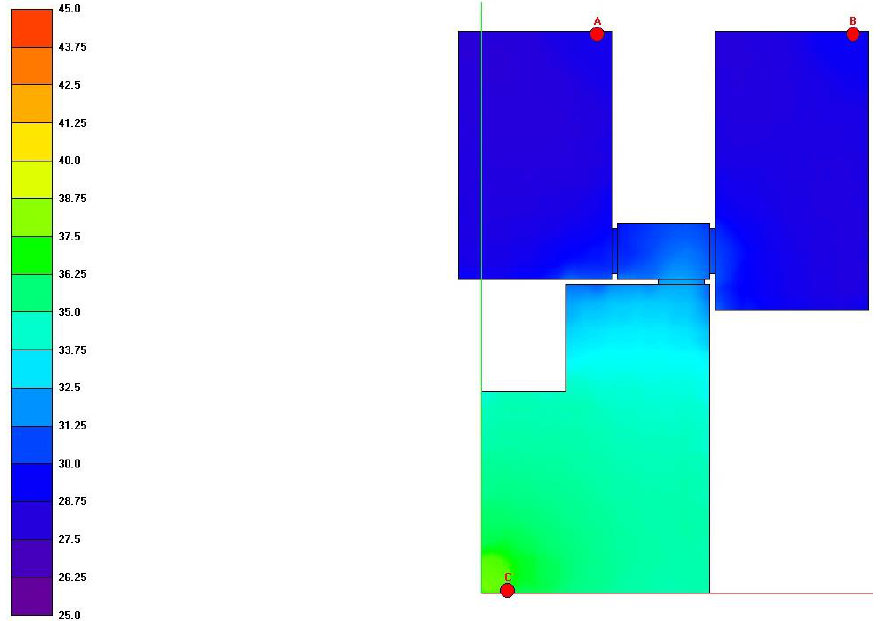
Figure 10. CM CMV A-weighted sound power levels L wA . First of all, the rooms surface absorption coefficients, of the three rooms, have been chosen in such a way as to obtain a mean reverberation time T 20, from 125 Hz to 4000 Hz in 1/1 octave bands, within ± 20% in respect to the measured values. Then, the equivalent sound pressure levels L Aeq in the rooms, for the three configurations, were simulated in such a way as to obtain a value within ± 1 dB(A) with respect to that measured. The sound pressure levels of the calibrated model of the configuration 1 are shown in Figure 11.